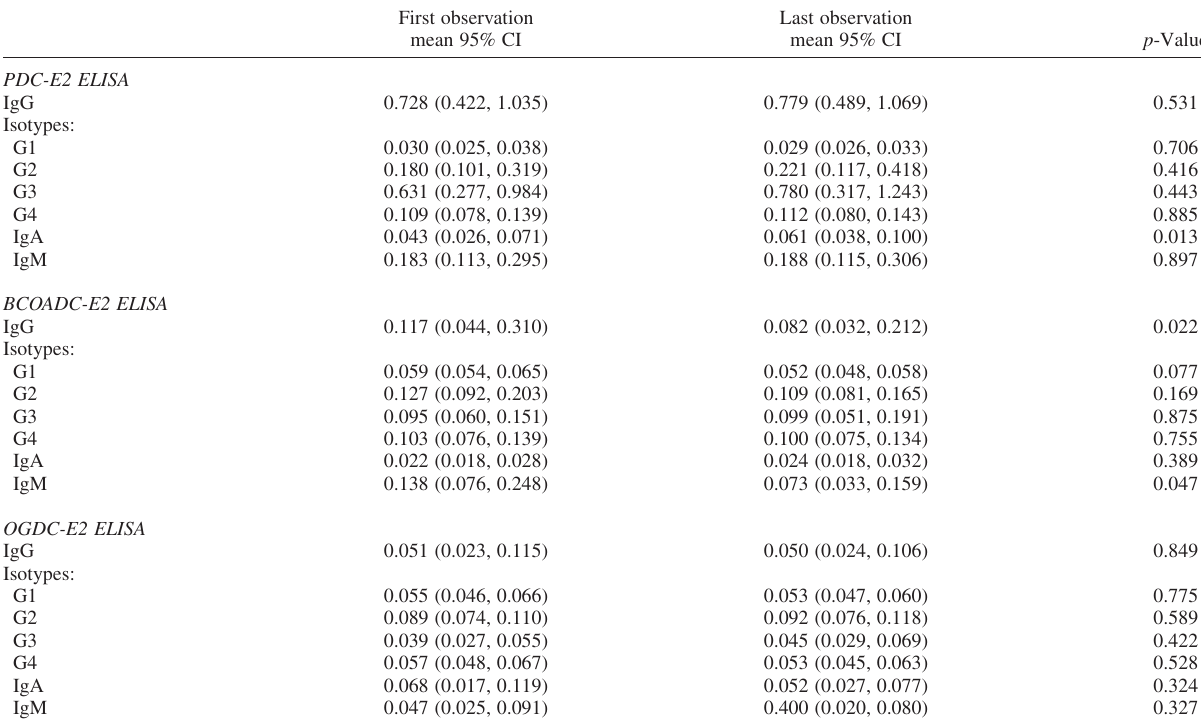
N ¼ 19; mean duration of 13.5 years. In sera collected at the time of diagnosis, 18/19 (95%) showed a reaction with PDC-E2, 15/19 (79%) with BCOADC-E2 and 12/19 (63%) with OGDC-E2. Serum from a single patient (5%) reacted only with BCOADC-E2. There were no significant changes between sera collected at the beginning and end of